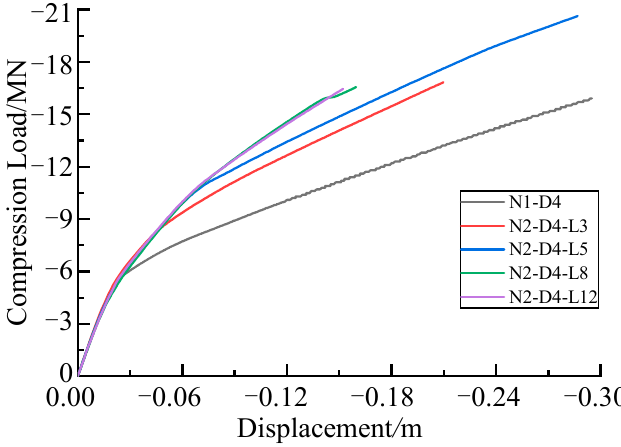
Figure 24. Compressive load-displacement curves ( D / d = 2, n = 2). Table 6. Compression efficiency coefficient ( D / d = 2, n = 2).